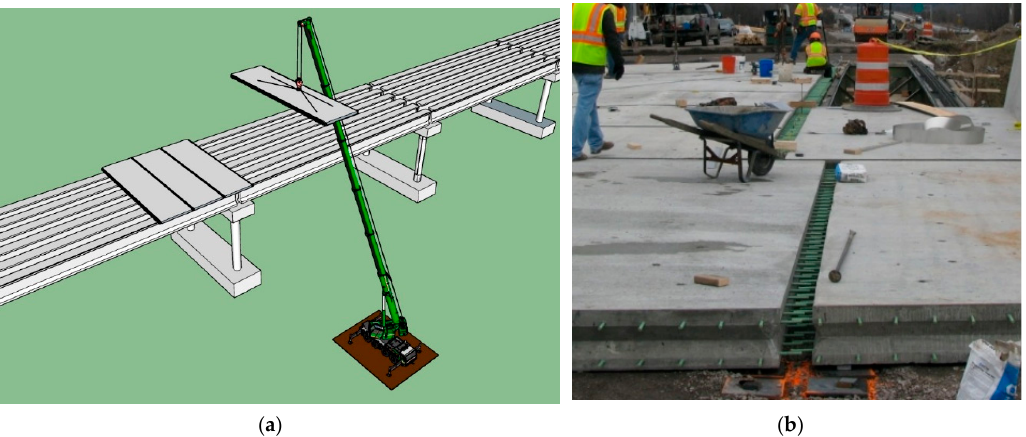
Figure 1. Schematic for full-depth deck precast panel used in ABC: (a) construction of precast deck panels; (b) actual construction [6].